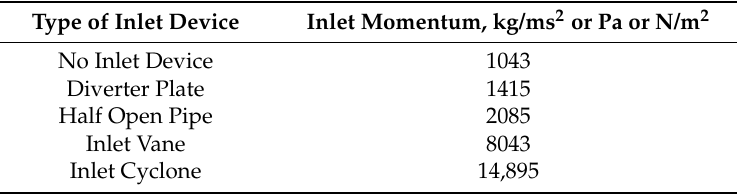
Table 1. Recommended inlet device according to inlet momentum limit